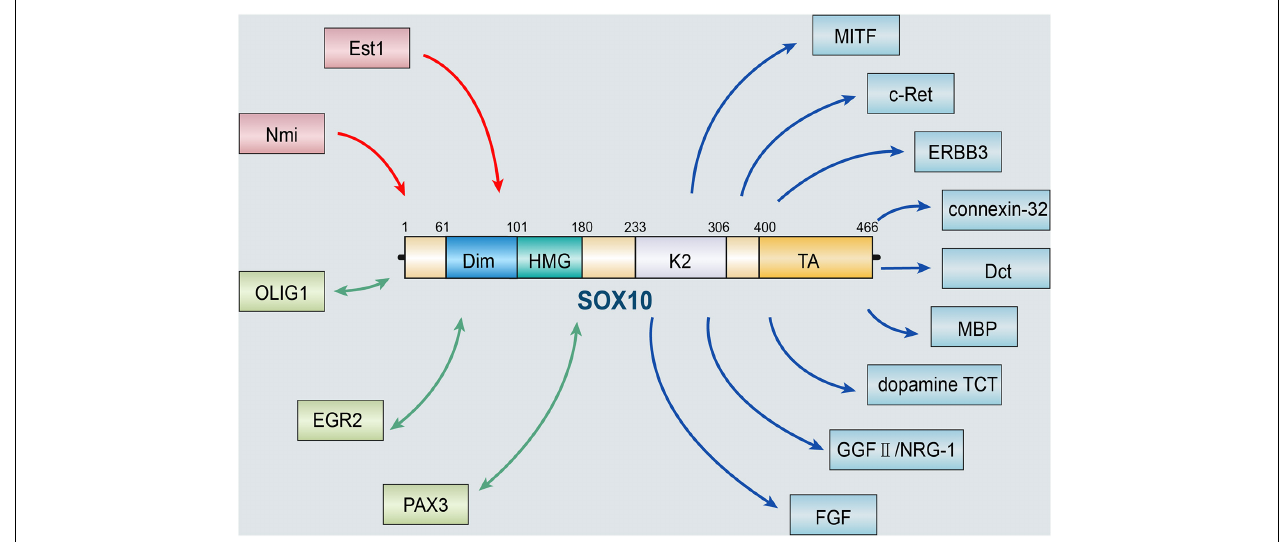
FIGURE 1 | SOX10 and its upstream and downstream targets. The role of SOX10 depends on the activation and regulation of various upstream molecules, including Est1 and Nmi. SOX10 can also act synergistically with a variety of molecules, such as OLIG1, EGR2, and PAX3. Besides, several target genes of SOX10 have been identified, including MITF, ERBB3, c-Ret, and some terminal differentiation markers, such as genes for connexin-32, Dct, MBP, dopamine TCT, GGFII/NRG-1, and FGF (OLIG1, oligodendrocyte transcription factor 1; EGR2, early growth response protein 2; PAX3, paired box gene 3; MITF, microphthalmia-associated transcription factor; ERBB3, epidermal growth factor receptor 3; Dct, dopachrome tautomerase; MBP, myelin basic protein; BMP2, bone morphogenetic protein 2; GGFII, glial growth factor II; NRG-1, neuregulin-1; FGF, fibroblast growth